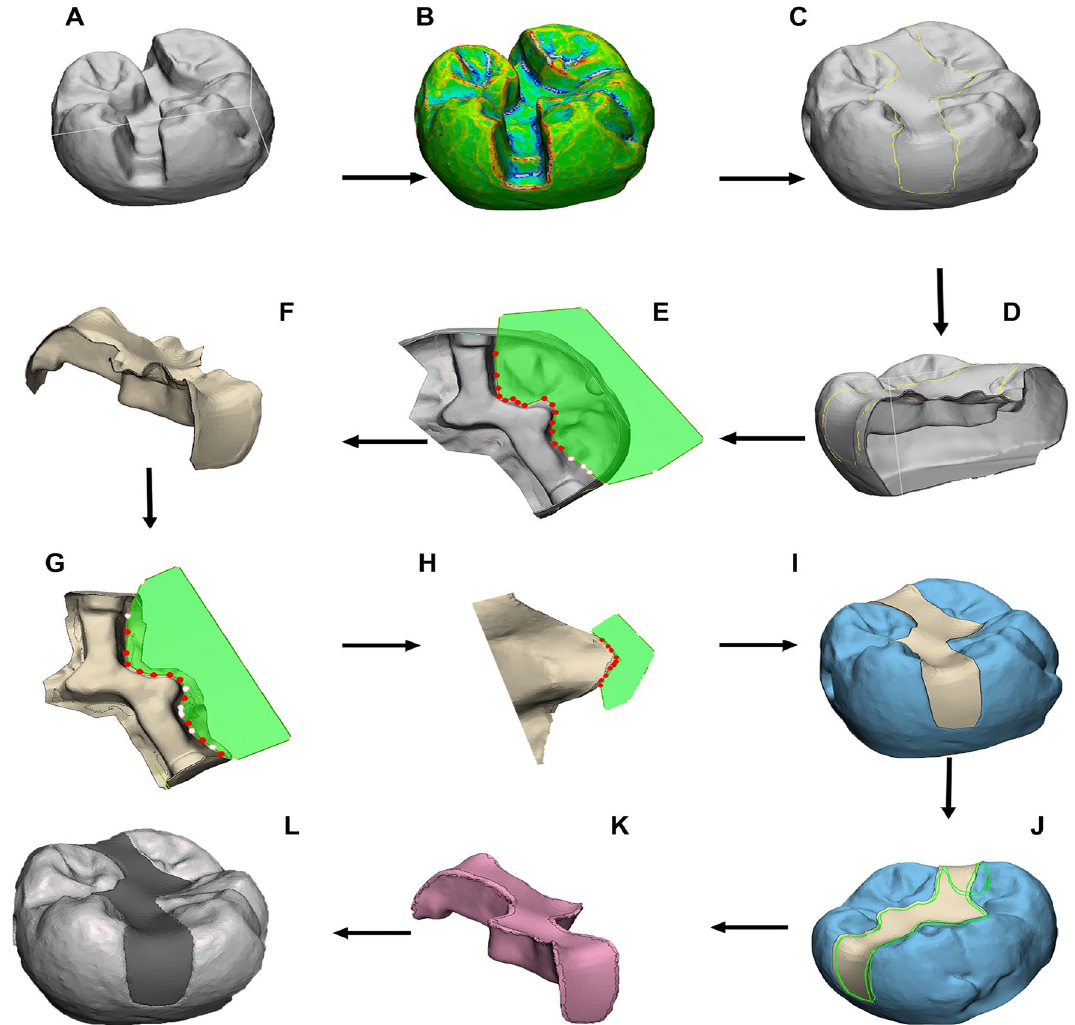
Figure 1. Workflow 1 for inlay design with respective commands: ( A ) 3D model loaded into 3-matics, ( B ) curvature analysis and curve creation on model surface, ( C ) surface reconstruction function to bridge defect , ( D ) hollow the model and trim down, ( E ) manual trimming of isolated segments, ( F ) apply wrap function, G) manually trim after wrapping, ( H ) manually trim any overhangs, ( I ) check fit onto 3D preparation model, ( J ) fine smoothing of edges, ( K ) final wrap and apply autofix function to fix any defects, ( L ) final